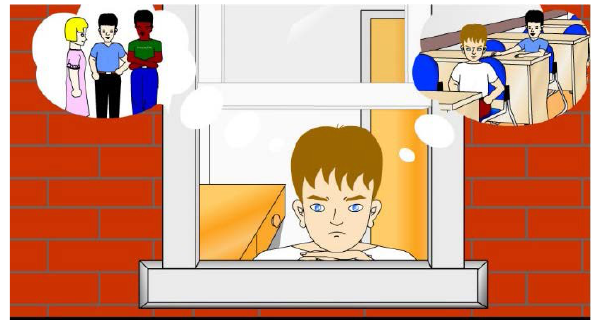
Figure 2. Design ideas crafted in